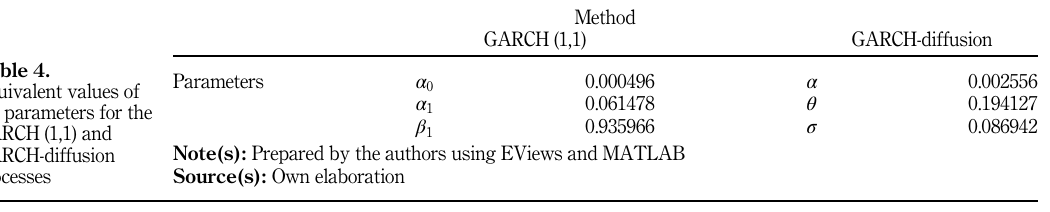
Table 5. Comparison of the value of the strategic NPV through the quadrinomial method and the binomial traditional